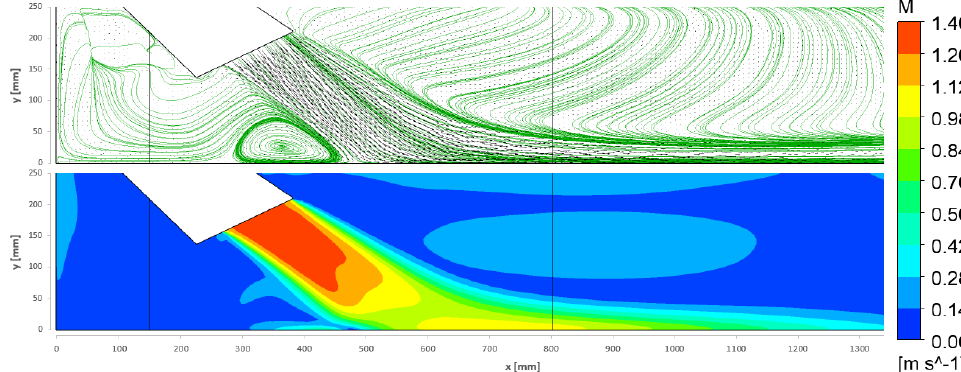
Figure 11. Finite volume method (SST model), vector lines ( top ) and the magnitude of time-averaged 2D velocity ( bottom ) in vertical plane ( z = 0mm ) .